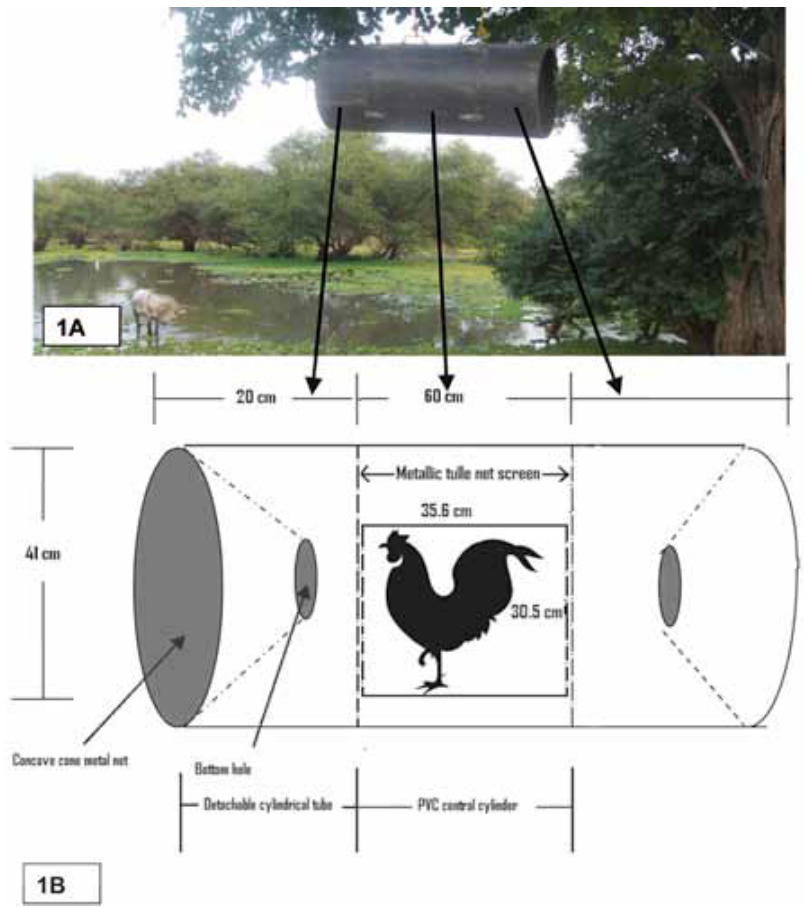
Fig. 2. – Photograph (1a) and diagram (1B) of the bird-baited trap (adapted from lepore et al.,